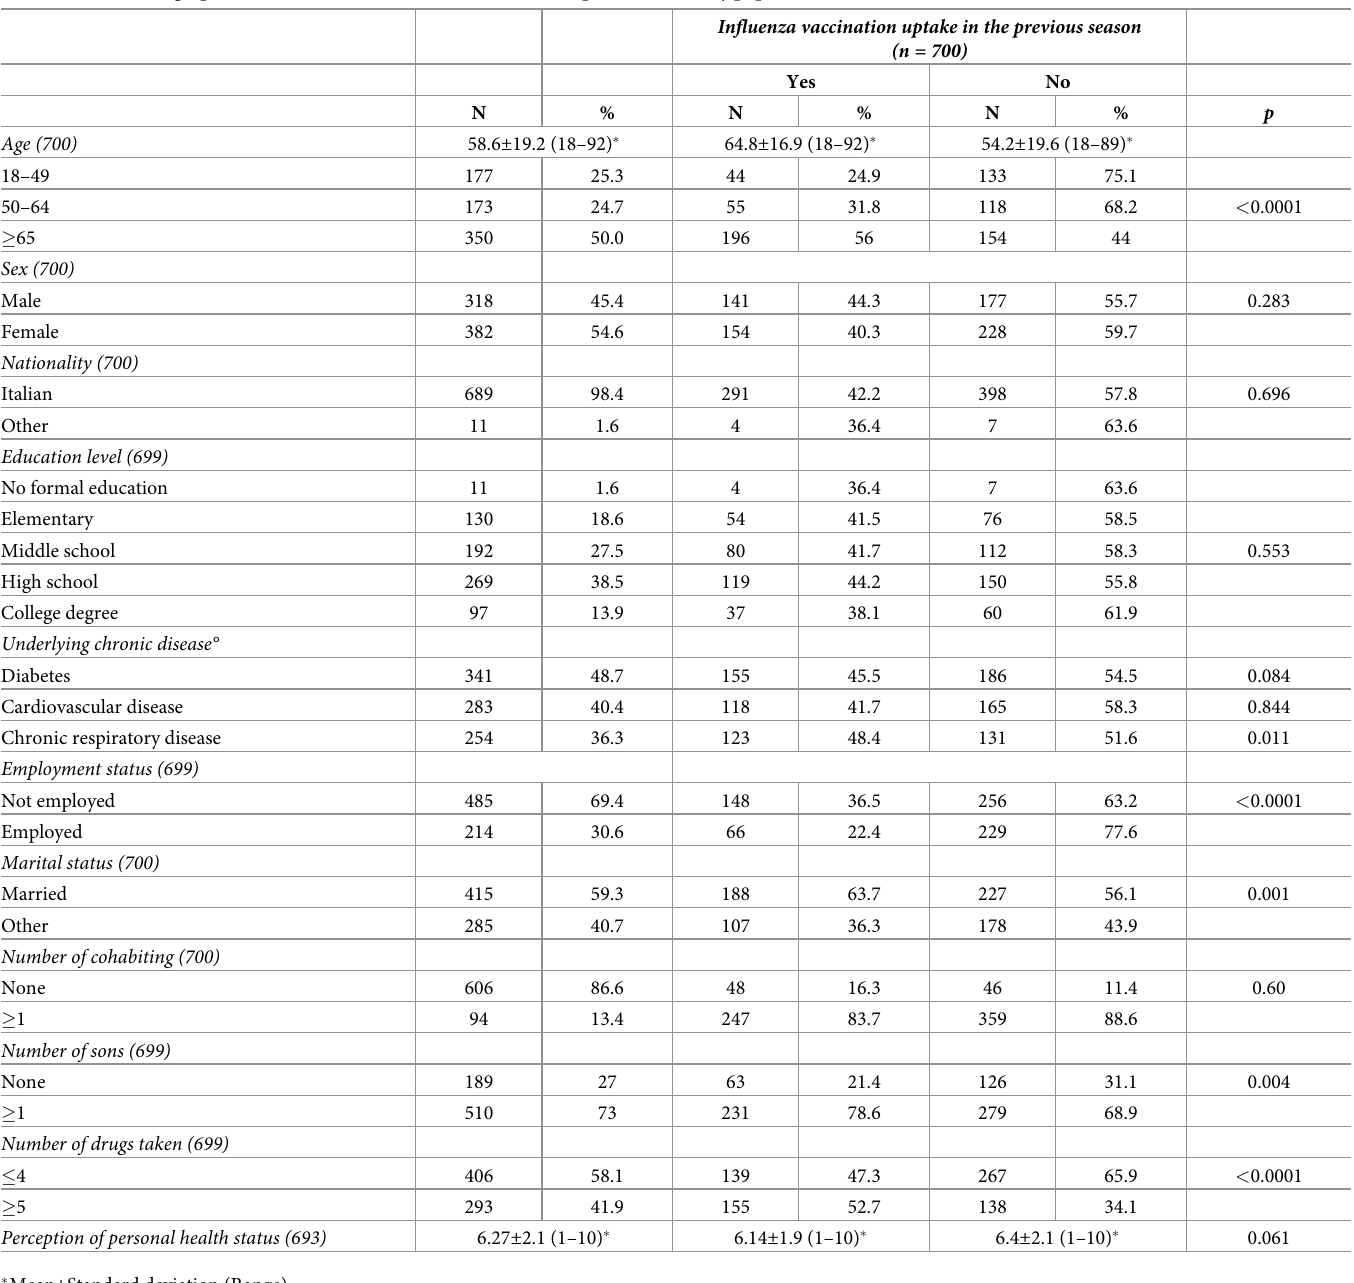
Table 1. Socio-demographic informations and influenza vaccination uptake of the study